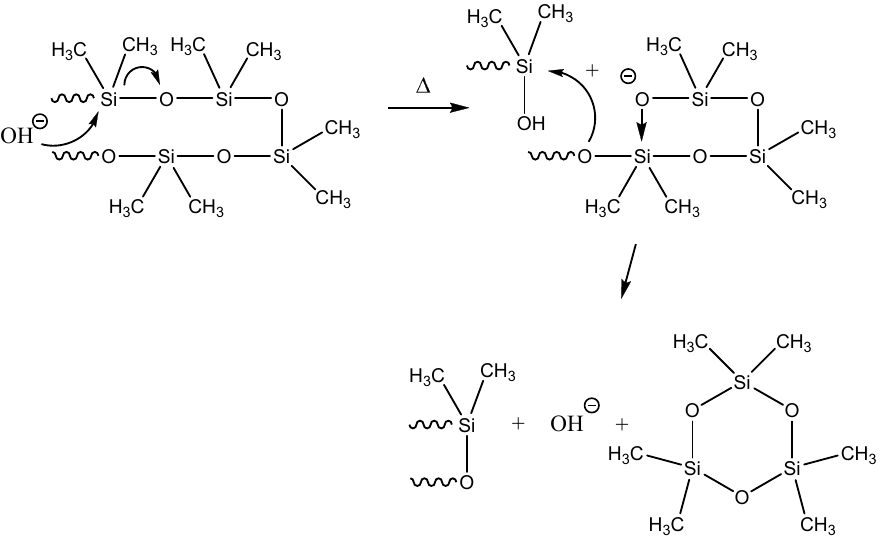
Figure 2. Process of thermal decomposition of PDMS in the presence of KOH. Adapted from Ref. [21] by permission from Springer, copyright 2000.